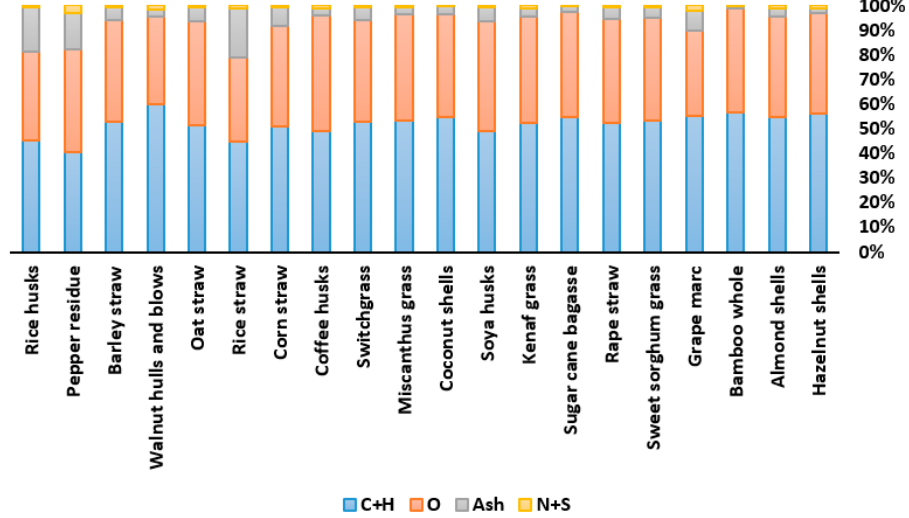
Figure 3. Percentage shares of composition elements for different H&ABs.